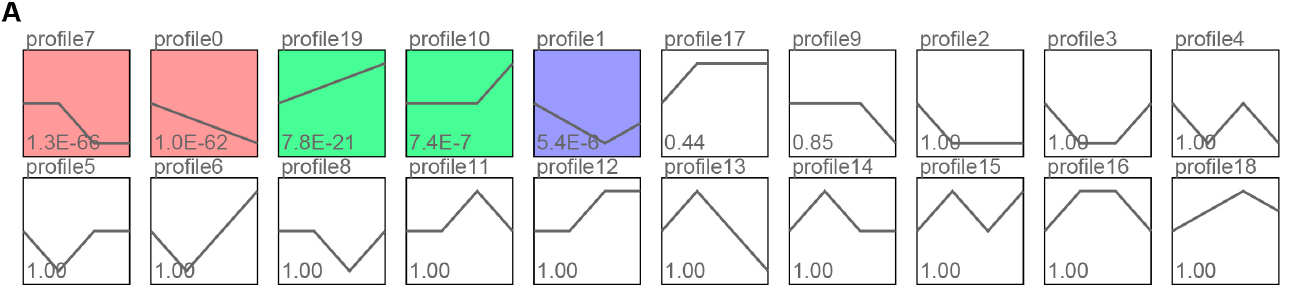
Figure 4. Trend and function enrichment analysis of mRNAs in the ceRNA network: ( A ) trend analysis of mRNAs in the ceRNA network using STEM. The significantly enriched profiles are purple, green, and red colored ( p < 0.05). Colors rep- resent the categories clustered by gene profiles; ( B ) scatter plot of significantly enriched KEGG pathways of mRNAs in the increasing and decreasing profiles. The node size is proportional to the gene number. Red and turquoise represent path- ways of decreasing and increasing profiles, respectively. 3.5. Identification of Crucial lncRNA–miRNA–mRNA Interactions To identify crucial lncRNA–miRNA–mRNA interactions associated with pigeon skeletal muscle development, we calculated the connectivity of each node in the ceRNA network using Gephi software. The top five lncRNAs with the highest connectivity degree were classified as hub lncRNAs, including TCONS_00066712 , TCONS_00026594 , TCONS_00001557 , TCONS_00001553 , and TCONS_00003307 (Figure 5). All the five hub